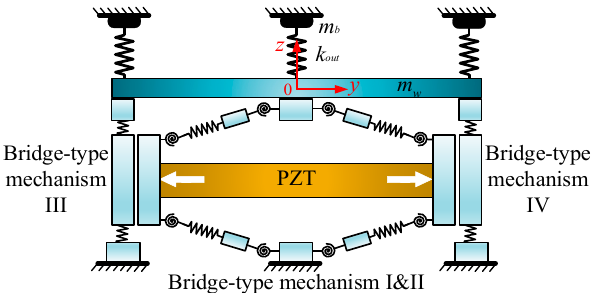
Figure 9. Mechanics model of the compliant platform in the Z direction.